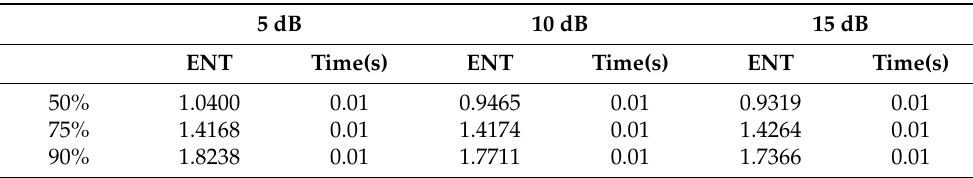
Table 11. Performance evaluation for another measured dataset with different loss rate under different SNR conditions.